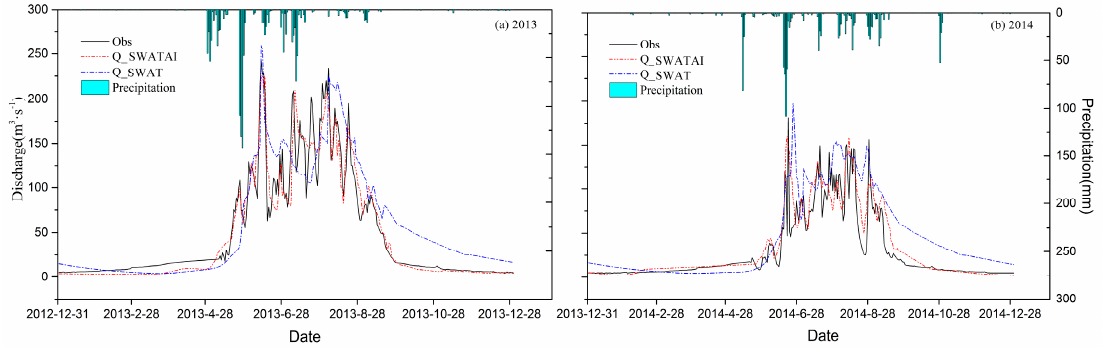
Figure 3. Comparison of simulation results from the SWAT and SWATAI models on the diurnal scale.